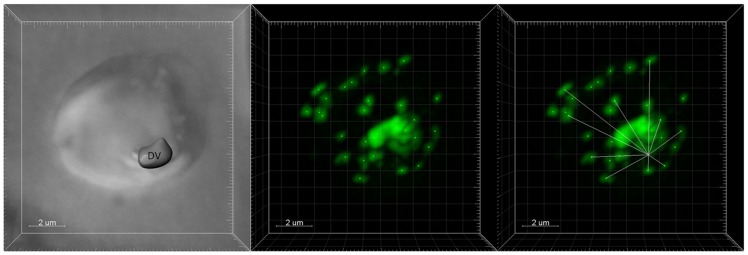
Semi automated computational method for quantifying the distribution of ATG8 puncta relative to hemozoin crystals within the DV.(A) Hemozoin within the DV is detected by transmittance, the outline of <10% transmittance is defined (labeled “DV”, left panel) and the center of this outline then defined by voxel analysis using Imaris software. (B) The center of distinct ATG8 puncta (bright green dots) are labeled using the option ‘Add new measurement points’ in the Imaris “spots” subroutine. (C) Distances from the hemozoin center to the ATG8 puncta centers are then computed (white lines) and data collated in excel.